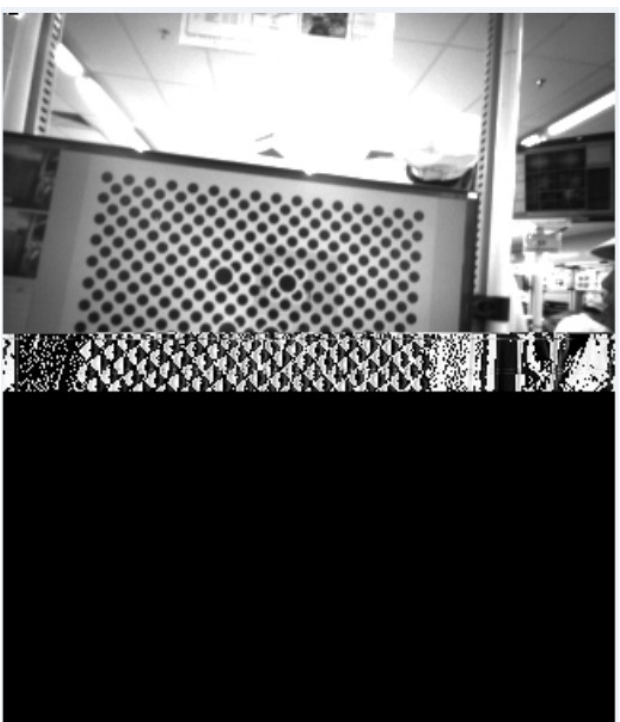
Figure 9. A deleted picture recovered from